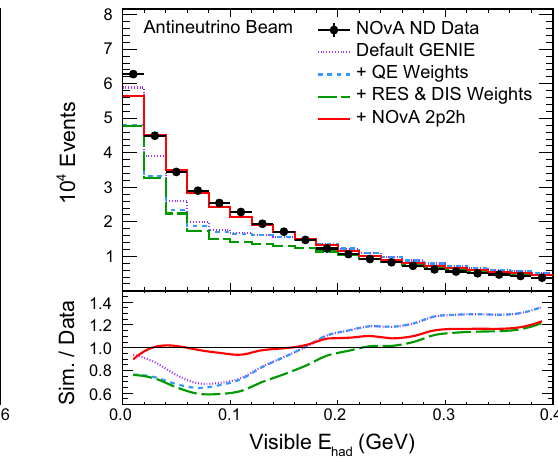
(DIS) adjustments are then also included, as shown by the green bro- ken line. The red solid histogram shows the final result, which further includes the fitted 2p2h contribution. Neutrino beam is shown at left and antineutrino beam at right